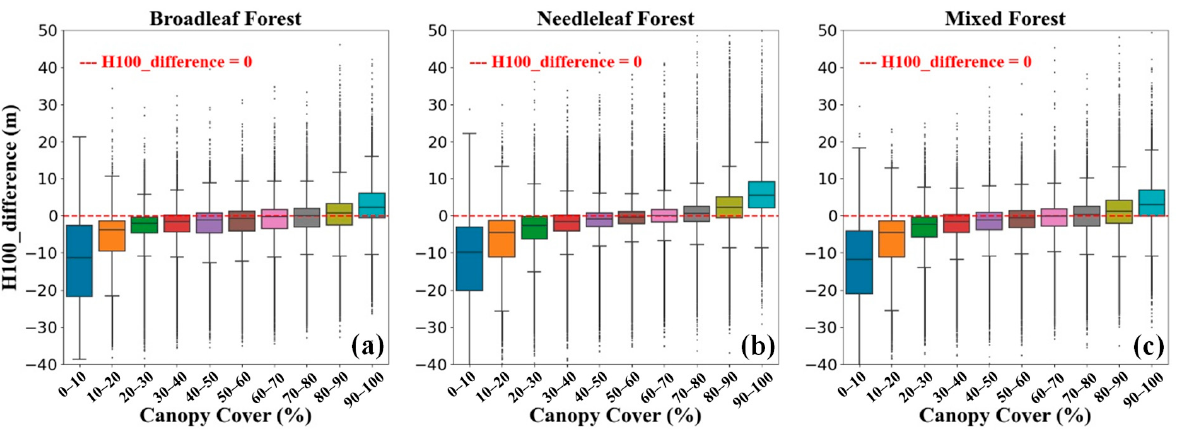
Figure 10. Boxplot of H_difference (GEDI H100-ALS Hmax) on canopy cover for ( a ) broadleaf, ( b ) needleleaf, and ( c ) Mixed forest.